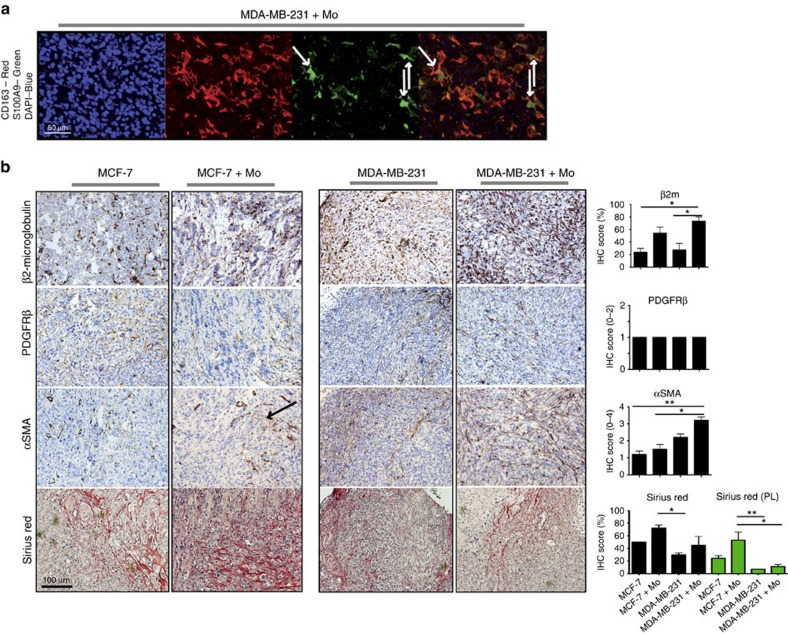
IHC of xenografts.Tumour xenografts consisting of TN MDA-MB-231 breast cancer cells co-transplanted with primary human monocytes, express more activated stromal markers than luminal A MCF-7/monocyte xenografts. Xenografts were grown in highly immunodeficient NSG-mice (see ‘Methods' section). (a) Immunofluorescence staining of CD163 (TRITC, red) and S100A9 (FITC, green) in sections from MDA-MB-231/monocytes xenograft tumours (day 21). DAPI (blue) shows nuclear staining. Overlay of colours is shown in lower right panel. S100A9 expression is located in the CD163+ human myeloid co-transplanted cells. White arrows indicate three cells with co-expression of CD163+ and S100A9. The cell lines are negative for S100A9 (ref. 21). (b) IHC was performed using the indicated antibodies and histological stains. All histological sections were counterstained with HE. N=5 mice were analyzed for each group; The black arrows indicate activated stroma. MCF-7 grafts were analysed on day 21 and 90 post-graft with similar results—day 90 is shown here; TN MDA-MB-231 grafts were grown to day 21 only. The histograms show the mean value for each IHC score with statistical analyses. IHC scores are shown in Supplementary Table 1. *=P<0.05, **=P<0.01 ANOVA non-parametric Kruskal–Wallis test. N=5. Error bars indicate s.e.m.